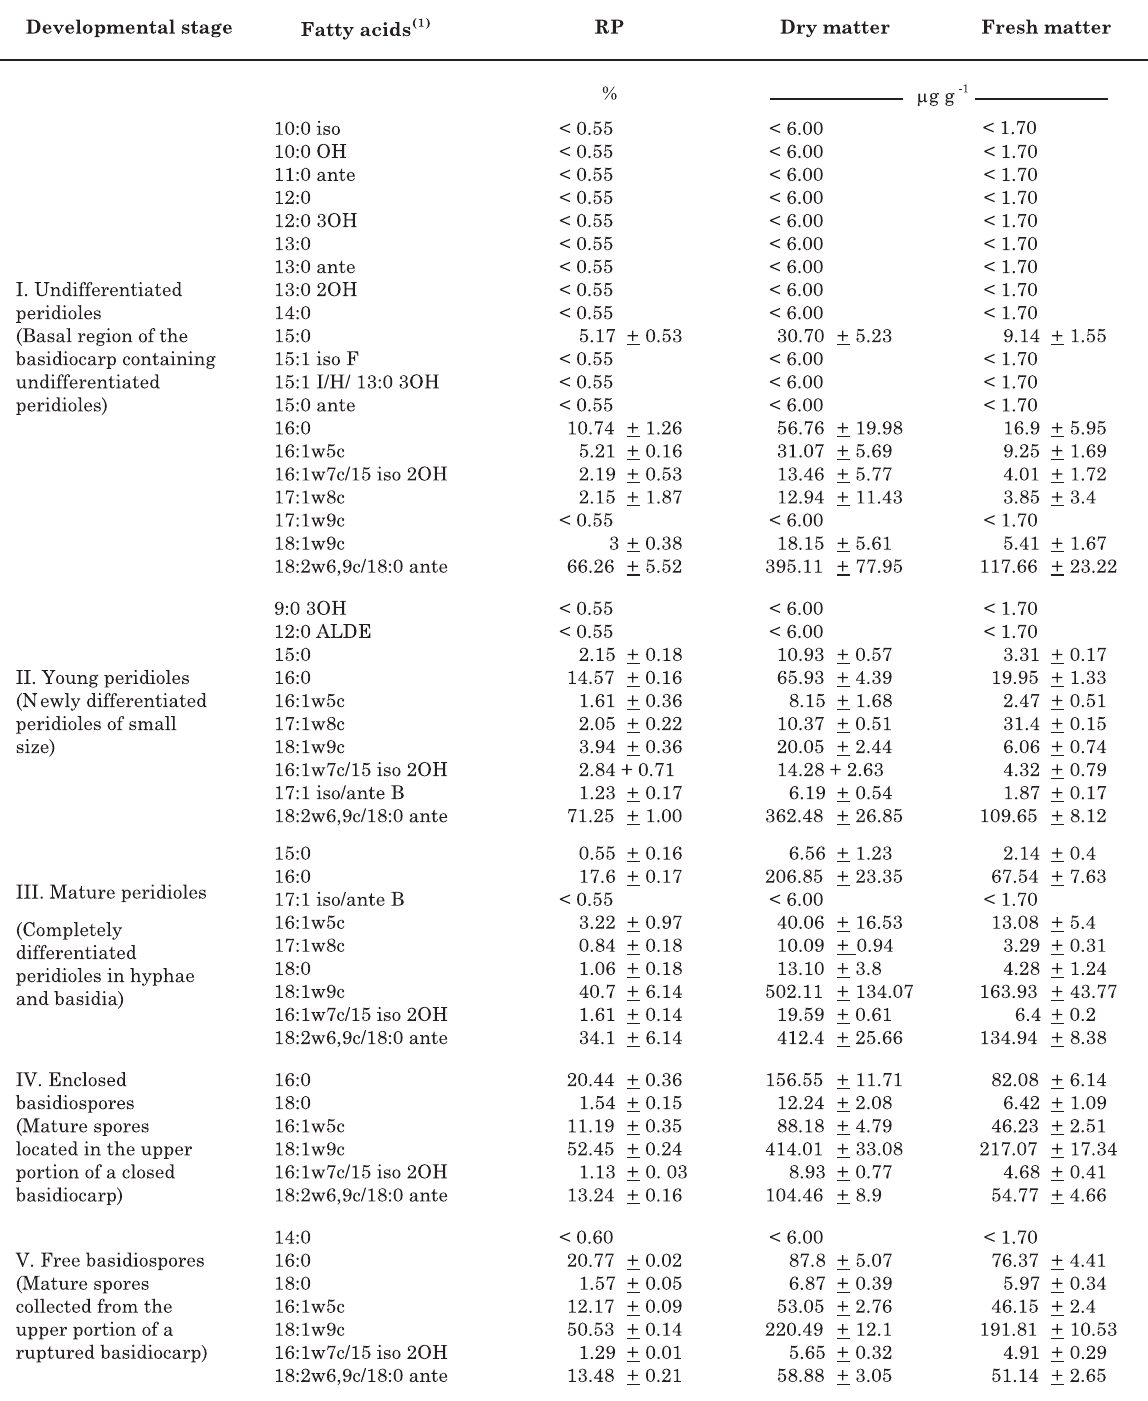
Table 1. Relative percentage (RP) and concentration of fatty acids of Pisolithus sp. basidiocarp sections characterized by the distinct developmental stages of